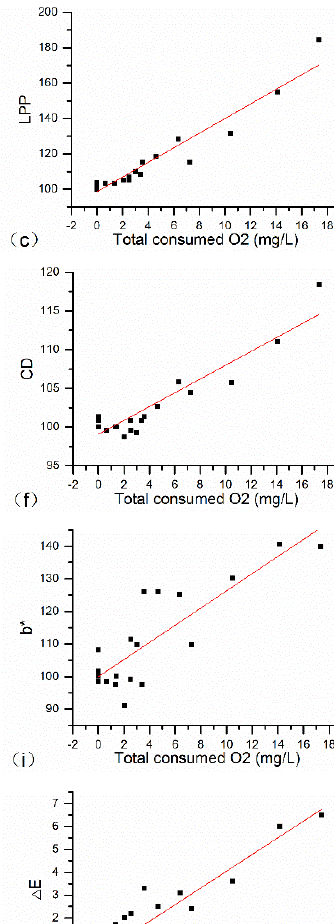
(%) decreased 2.32% per mg/L of consumed O 2, proving the loss of native anthocyanins.